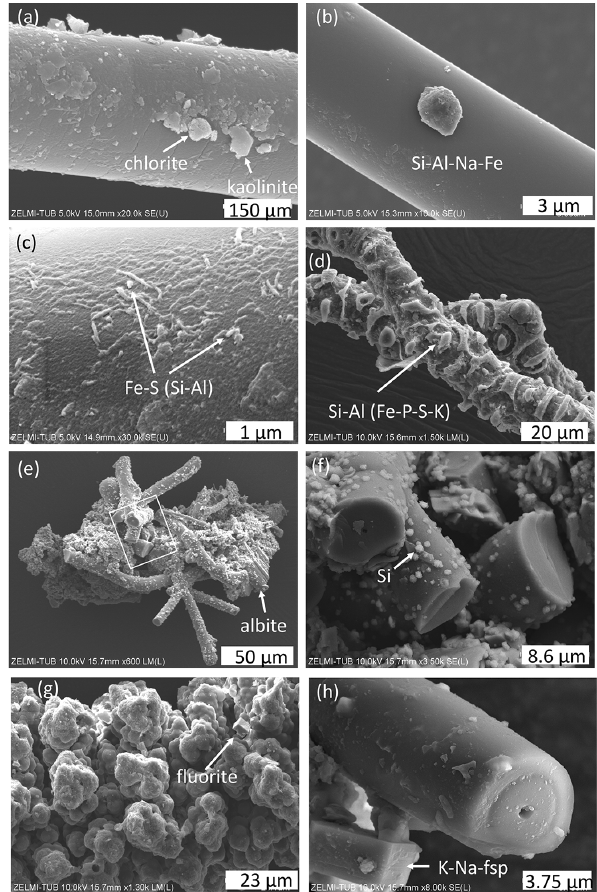
Figure 3. SEM images of kerite fossils, illustrating the different morphologies. (a) Filamentous and flaky kerite in etch pits of beryl (sample #10). (b) Spherical object on a filament (sample #10). (c) Flaky kerite (sample #10). (d, e) Enlarged particle of flaky kerite; white rectangle indicates position of (e) . (f) Branched filament with smooth surface (sample #4). (g) Filaments with a botryoidal and a smooth, slightly segmented surface (sample #5). (h) Filament with a strongly segmented surface (sample #2). EDS spectra of flaky kerite are shown in Fig. S2 in the Supplement.